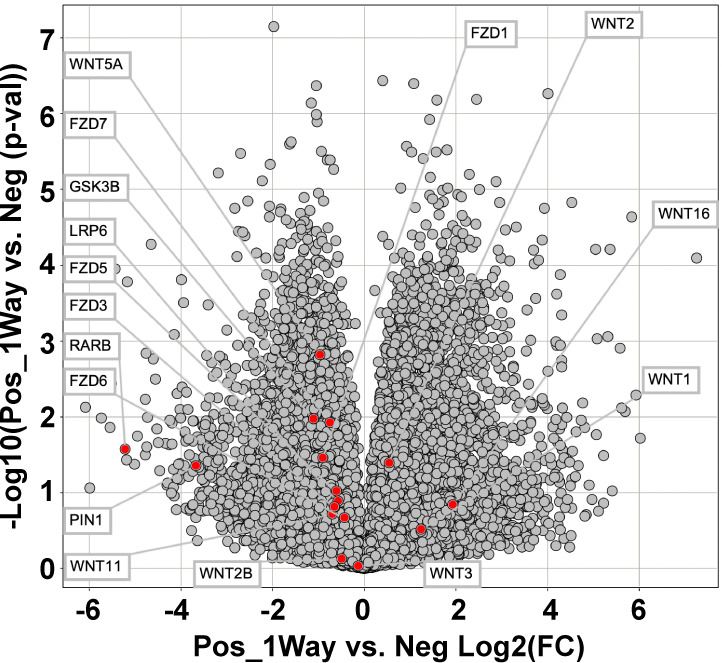
Expression of wnt-related genes among CD107alowCD31-CD45- and CD107ahighCD31-CD45- mesenchymal cells.Data were shown in volcano plot. All transcripts are shown in light gray, while the transcripts of interest are shown in red.